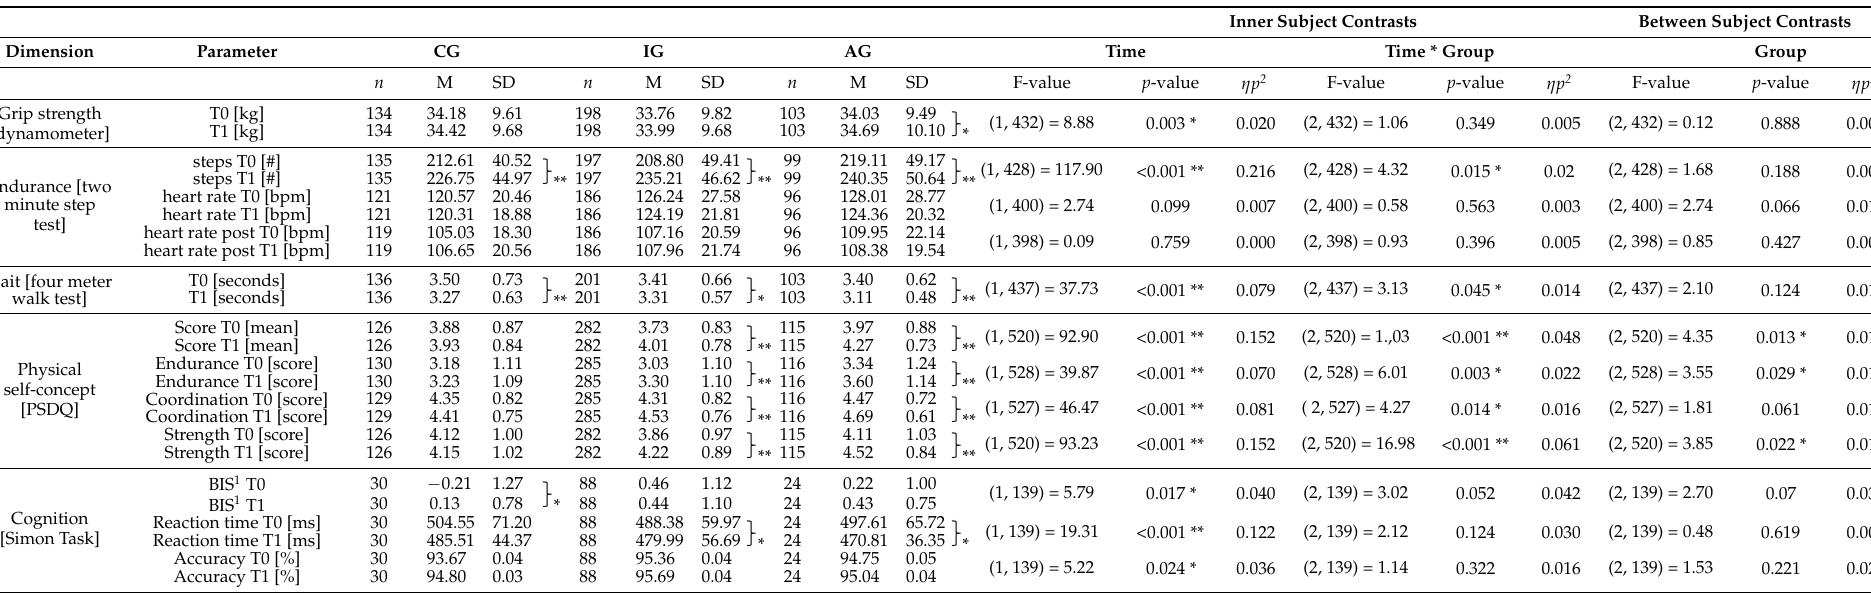
Table 2. Mean values (M), standard deviations (SD) and results of ANOVA for evaluated parameters of dependent variables separated by group (control group (CG), intervention group (IG) and activity tracker group (AG)). T0 = pre-test; T1 = post-test 12 weeks after